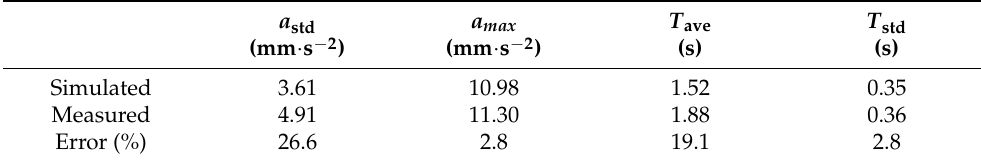
Table 4. Acceleration and period comparison between simulation and measurement.